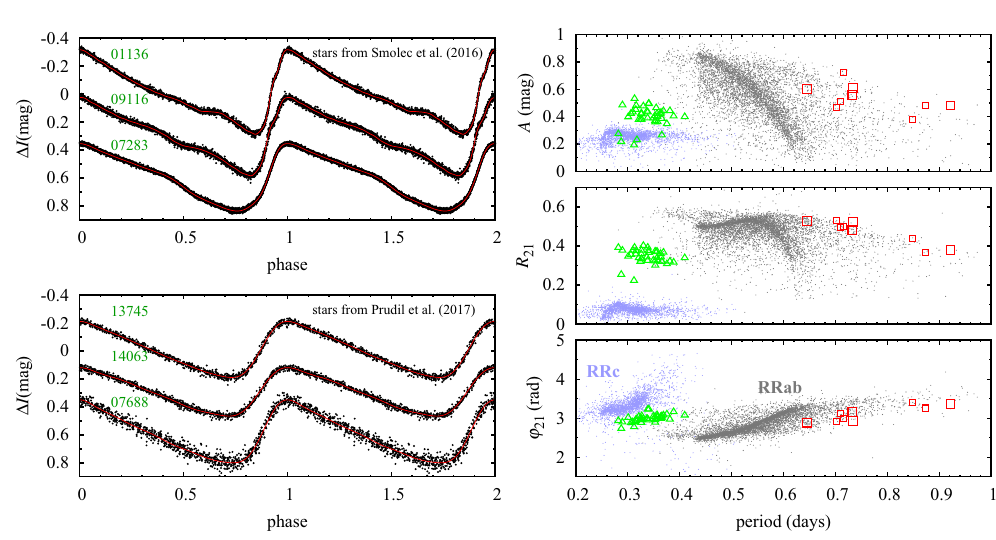
Figure 2. Left panels: exemplary light curves corresponding to the dominant periodicity in stars from Smolec et al. ([14], top) and Prudil et al. ([10], bottom). Star’s ids (OGLE-BLG-RRLYR-xxxxx) are given along each light curve. Right panel: peak-to-peak amplitudes and low-order Fourier parameters ( R 21 and ϕ 21 ) for all stars of these two groups. Symbols are the same as in Figure